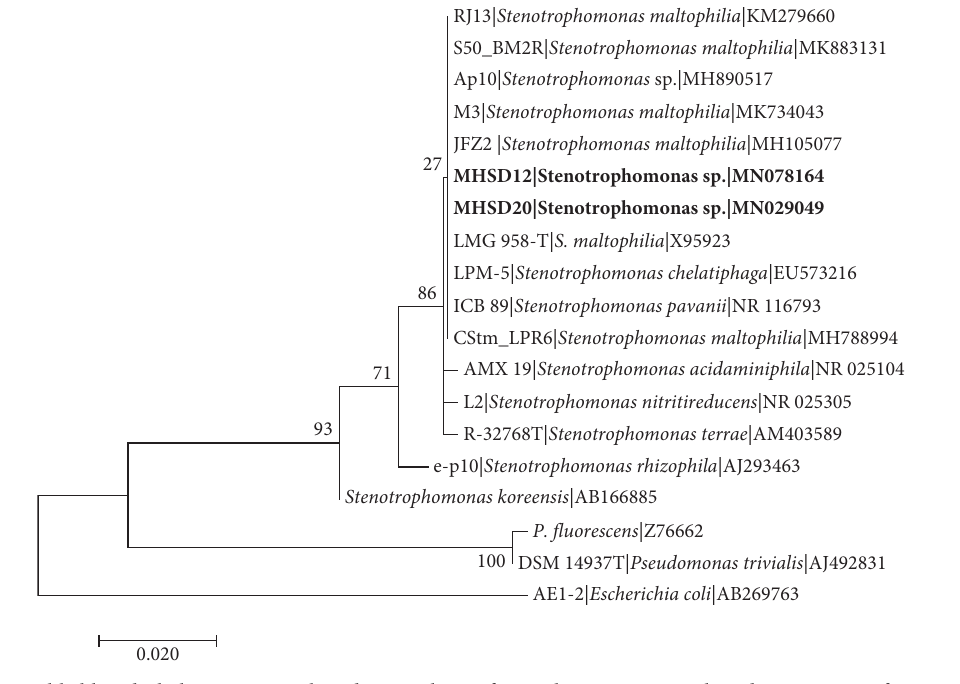
Figure 3: Maximum likelihood phylogenetic tree based on analysis of partial 16S rDNA nucleotide sequences of Stenotrophomonas sp. strain MHSD20 with related strains from Stenotrophomonas genus. Numbers above or below the nodes indicate bootstrap values generated after 1000 replications. Escherichia coli AE-1 (AB269763) was used as an